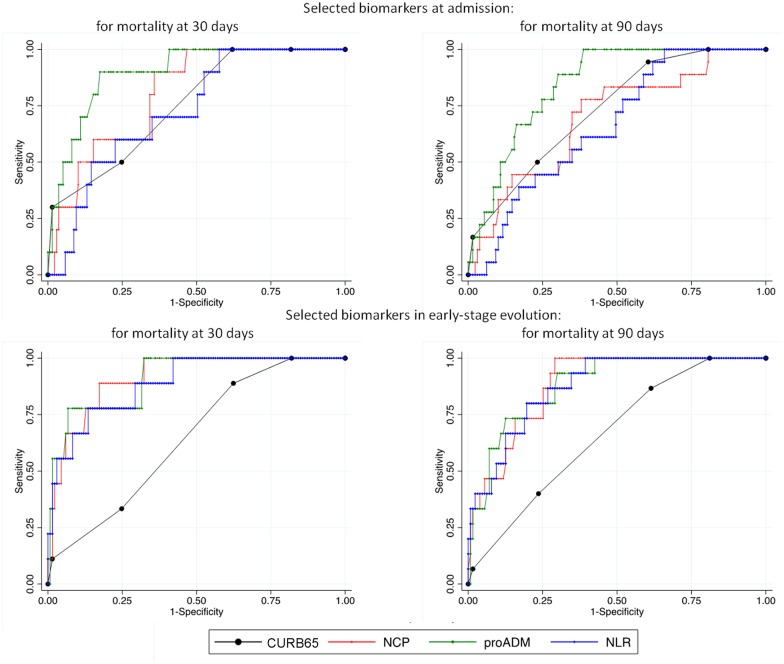
ROC Curves of CURB65 and selected biomarkers: Neutrophil Count Percentage (NCP), Proadrenomedullin (ProADM) and Neutrophil-Lymphocyte Ratio (NLR), in Blood Test at Admittance (Upper Panels) and in Early-Stage Evolution (Lower Panels), Referred to Mortality at 30 and 90 Days.